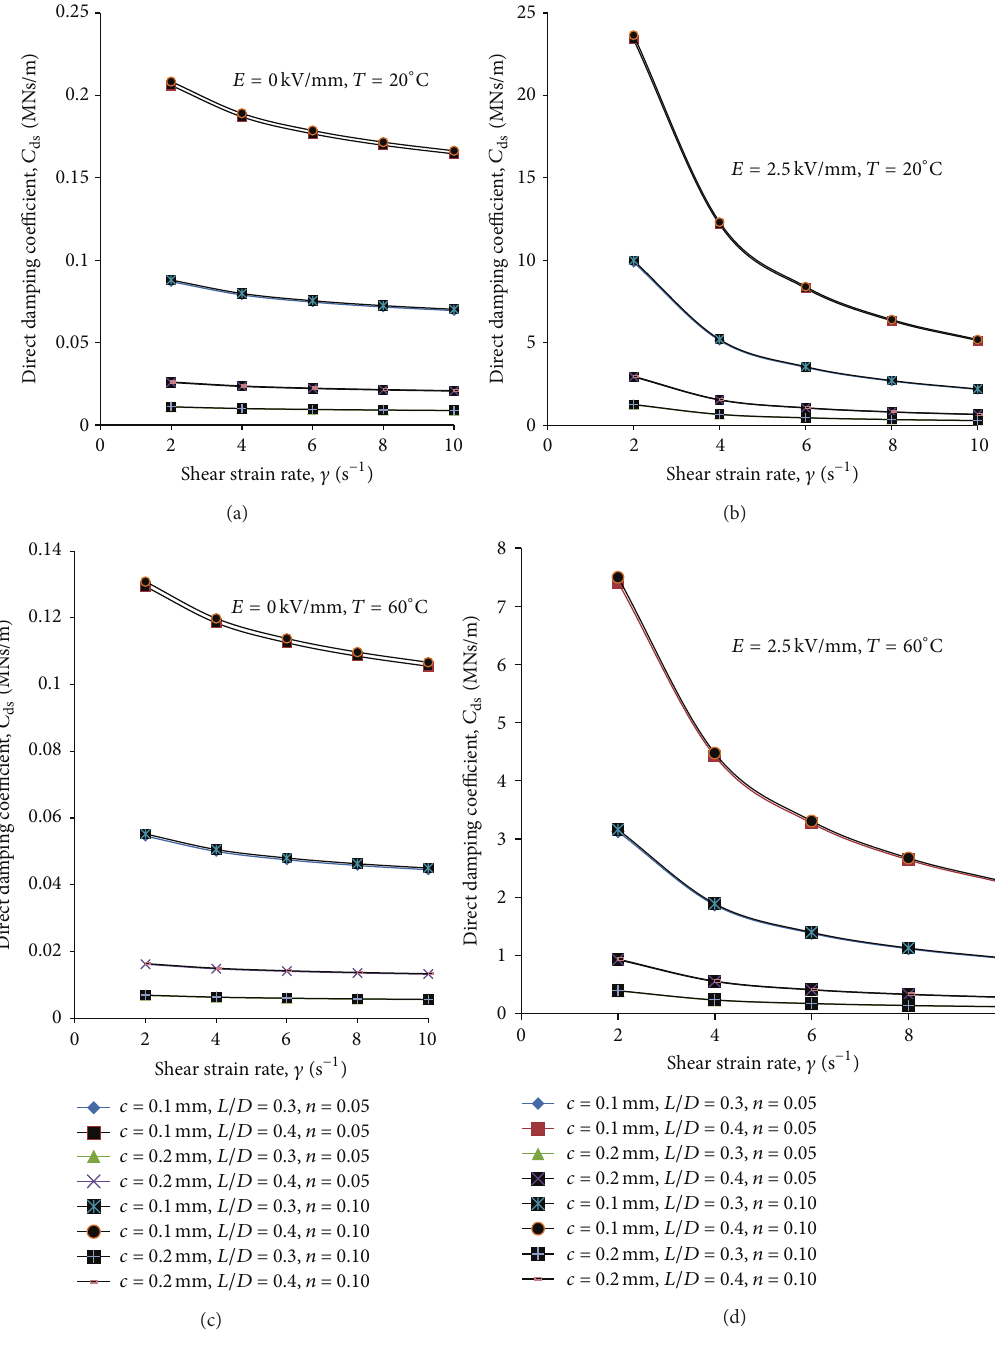
Figure 9: Direct damping coefficient, MNs/m versus shear strain rate, s −1 , for (a) 𝐸 = 0 kV/mm, 𝑇 = 20 ∘ C; (b) 𝐸 = 2.5 kV/mm, 𝑇 = 20 ∘ C; (c) 𝐸 = 0 kV/mm, 𝑇 = 60 ∘ C; and (d) 𝐸 = 2.5 kV/mm, 𝑇 = 60 ∘ C.